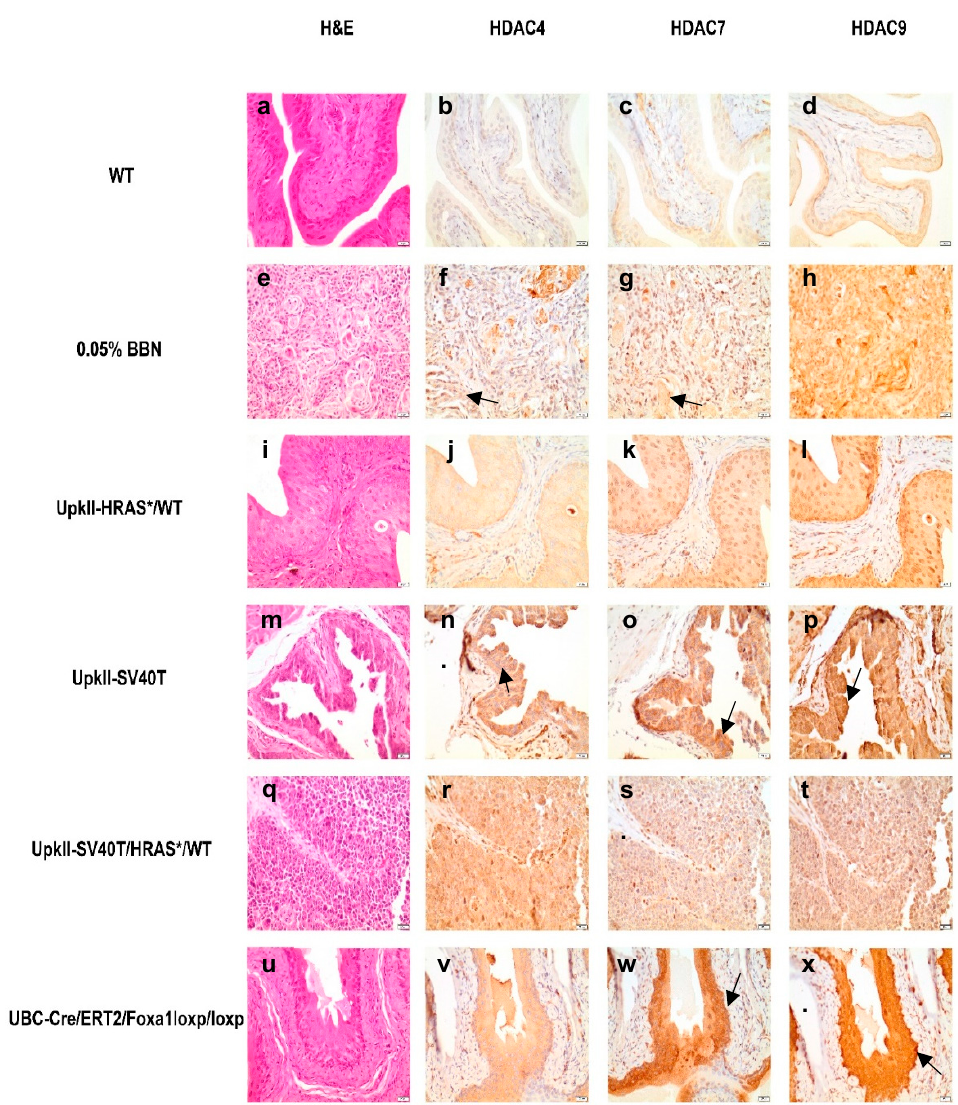
Figure 6. Increased expression of histone deacetylase (HDAC)4, -7, and -9 is observed in commonly used bladder cancer BC mouse models. In normal mouse epithelium ( a ), HDAC4 ( b ) and -7 ( c ) is not expressed and HDAC9 is positive ( d ). In mice treated with 0.05% N -Butyl- N -(4-hydroxbutyl)nitrosamine (BBN) for 20 weeks ( e ), we observed increased expression of HDAC4 ( f ) and -7 ( g ) in the cytoplasm, while Hdac9 was overexpressed in nuclei and cytoplasm ( h ). In UpkII-HRAS */WT mice ( i ), we observed increased expression for all three HDACs ( j - l ). In UpkII-SV40T mice ( m ), Hdac4 ( n ) and -7 ( o ) were overexpressed in the cytoplasm and Hdac9 ( p ) was overexpressed in the nuclei and cytoplasm. In UpkII-SV40T/HRAS */WT mice ( q ), we observed overexpression of Hdac4 ( r ) in nuclei and cytoplasm as well as increased expression in Hdac7 ( s ) and -9 ( t ) but primarily in the cytoplasm. Finally, in UBC-Cre/ERT2/Foxa1 loxp/loxp mice ( u ), we observed increased Hdac4 expression ( v ), however, Hdac7 ( w ) and -9 ( x ) were overexpressed with intense staining observed in the basal cell populations. Black arrows are pointing towards area of interest as described.